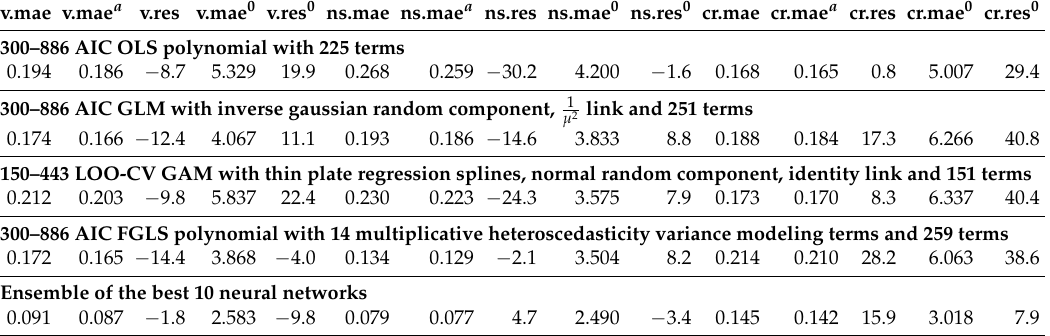
Table 2. Validation figures for the best OLS and FGLS polynomials, GLM and GAM, derived in Krah et al. (2020), and the ensemble of 10 best performing neural networks. MAEs in %.